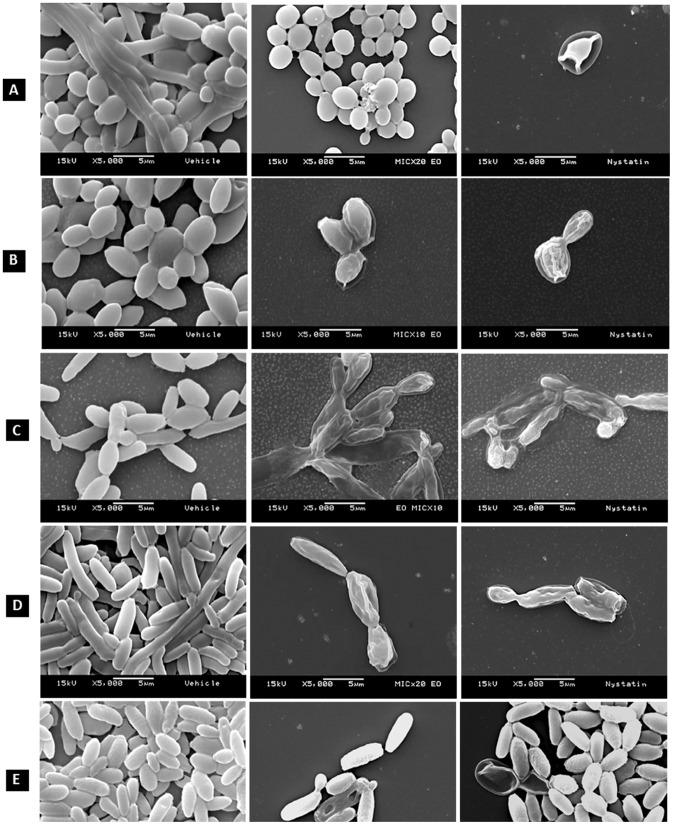
Effects on biofilm morphology.SEM Photomicrographs (5,000x) showing Candida biofilm cells after treatment with propylene glycol (vehicle) (left-sided), essential oil from C. sativum leaves (middle-sided) and nystatin (right-sided). The most representative cell injuries were caused by the following concentrations of the EO: (A) C. albicans – MIC times 20 (312.5 µg/ml); (B) C. tropicalis – MIC times 10 (312.5 µg/ml); (C) C. krusei – MIC times 10 (156.0 µg/ml); (D) C. dubliniensis – MIC times 20 (625 µg/ml); and (E) C. rugosa – MIC times 20 (312.5 µg/ml). Nystatin was tested at MIC against all strains (see MIC values in Table 2) and the vehicle did not affect the biofilm integrity.